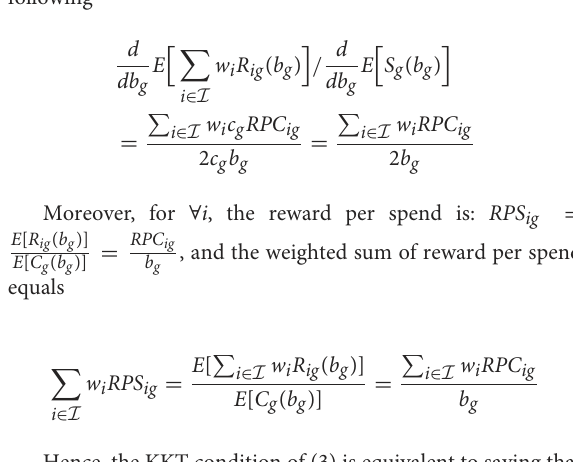
Figure 1. In Figure 1, the first task for obtaining the reward per click ( RPC i ) predictions for each type of reward i is clustering the pool of SEM ads into ad groups. It consists of two steps: 1. building a representation learning model that encodes SEM